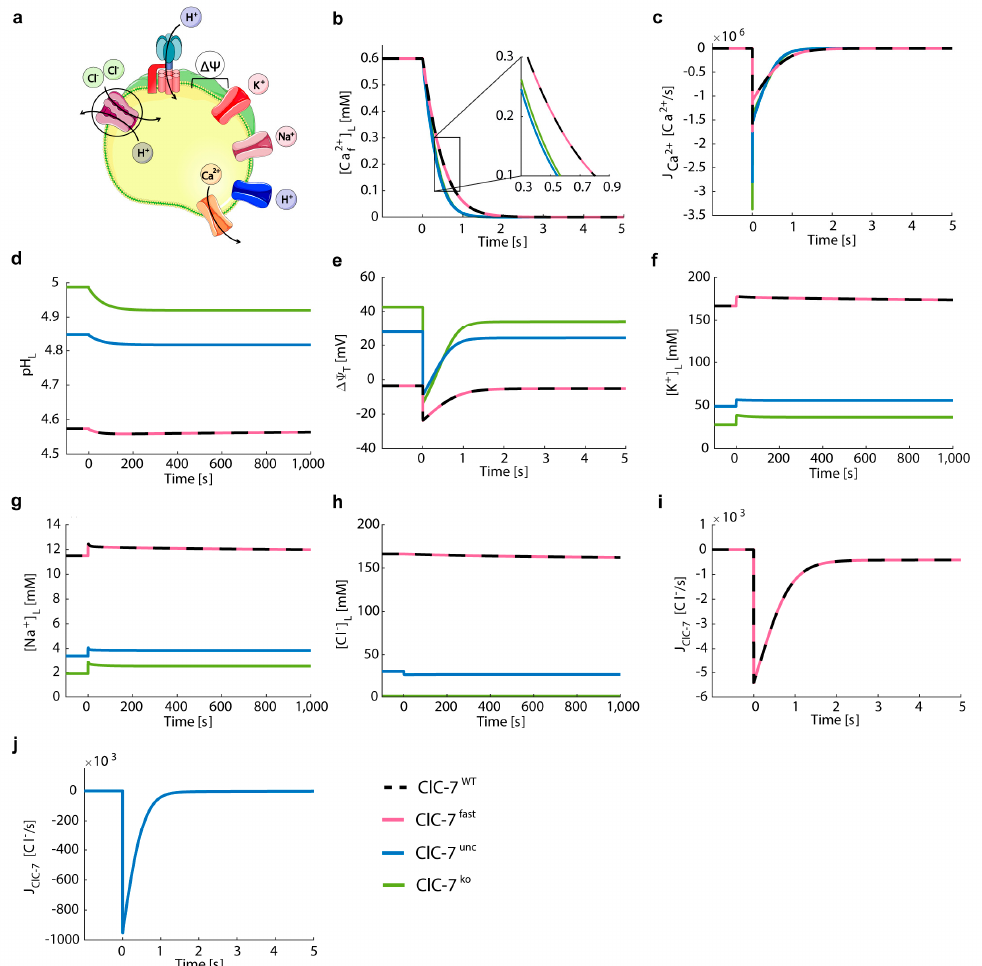
Figure 4. The cation channels Na + and K + neutralize the influence of ClC-7 on Ca 2+ release. ( a ) Schematic representation of the model with ClC-7 antiporters, V-ATPases, potassium and sodium channels, proton leak, and Ca 2+ release channel. The cartoon was created using Servier Medical Art templates (https://smart.servier.com), licensed under a Creative Commons License (https://creativecommons.org/licenses/by/3.0/). ( b – j ) Depicted for the different ClC-7 scenarios during triggered Ca 2+ release (ClC-7 WT , dashed black line; ClC-7 fast , red; ClC-7 unc , blue; ClC-7 ko , green) are ( b ) luminal free Ca 2+ concentration, ( c ) Ca 2+ flux, ( d ) luminal pH, ( e ) total membrane potential, ( f ) luminal concentrations of potassium, ( g ) sodium and ( h ) chloride ions, as well as the turnover rates of ( i ) ClC-7 WT and ClC-7 fast , and ( j ) ClC-7 unc . The initial conditions were set to the steady-state values of Figure 3 (Supplementary Table S3). From t = 0 s, the lysosomal membrane was permeable to calcium ions ( P Ca2+ = 8.9 × 10 − 5 cm/s).